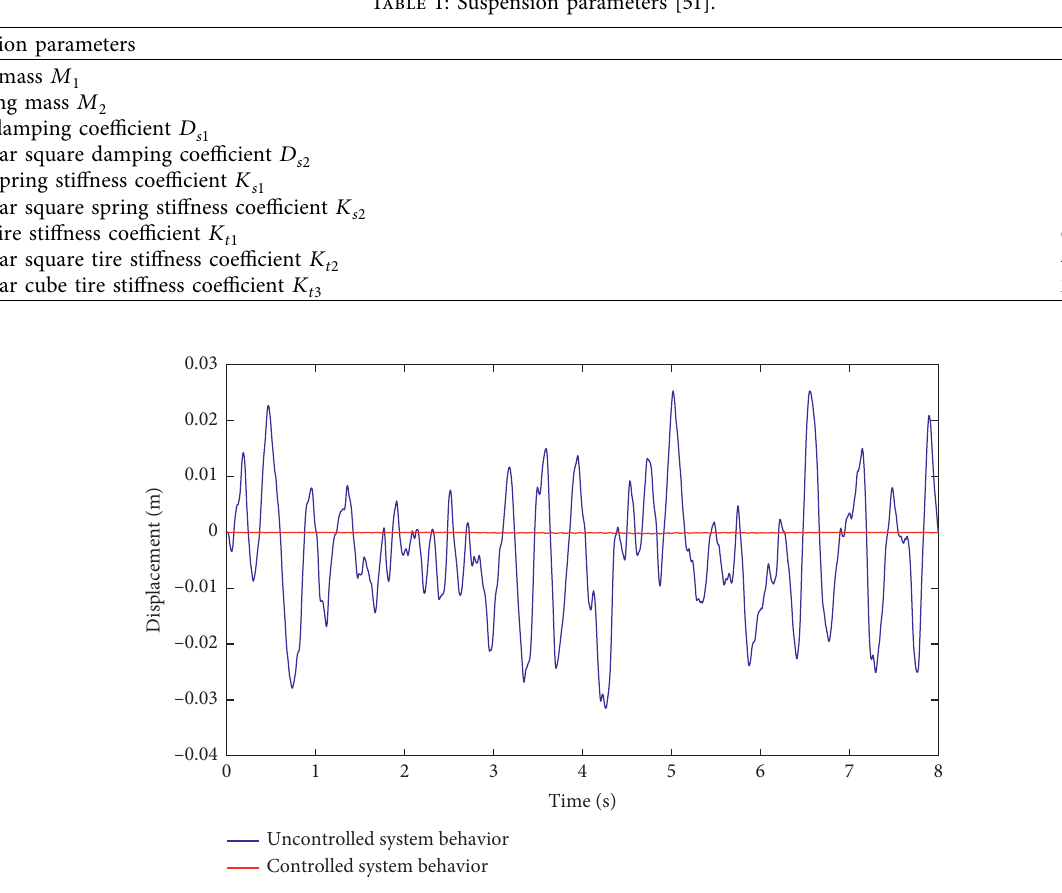
Figure 4: Uncontrolled and controlled system behavior using designed sliding mode controller for λ � 1 and η � 10.